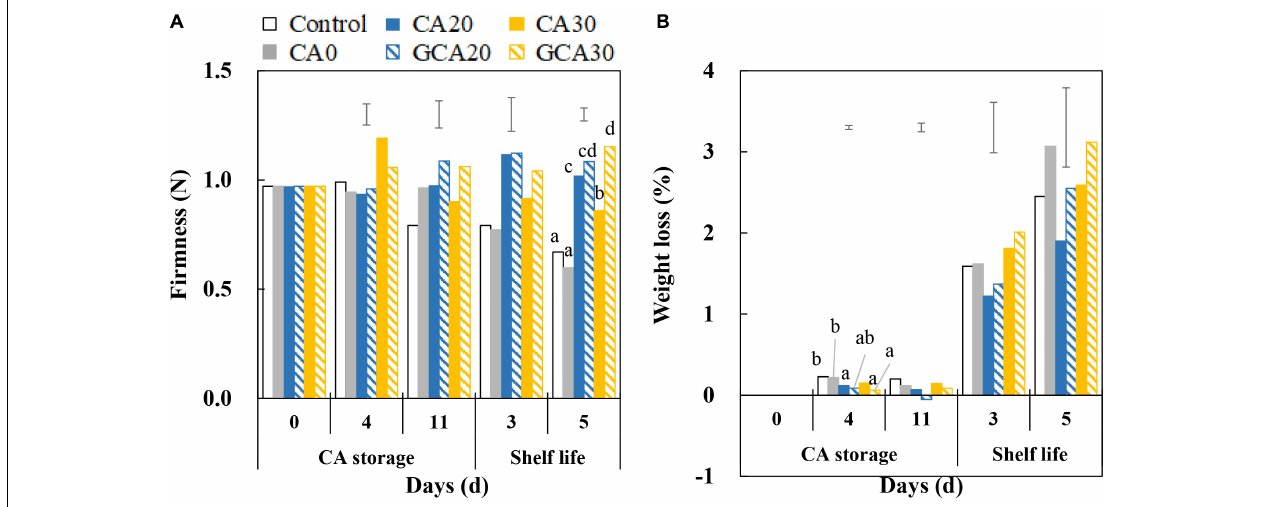
FIGURE 5 | Firmness and weight loss of “Arabella” strawberry fruit during CA storage and shelf life. (A) Firmness and (B) weight loss during CA storage at 5 ◦ C and ∼ 100% relative humidity and subsequent shelf life at 12 ◦ C and ∼ 95% relative humidity in ambient atmosphere. Data represent means of 2 blocks ( n = 2; each block being averaged of 20 replicated fruit). The error bars represent the standard error of means. Different letters denote significant differences according to Fisher’s protected LSD test ( α = 0.05). As a control condition, 21 kPa O 2 and 0 kPa CO 2 were